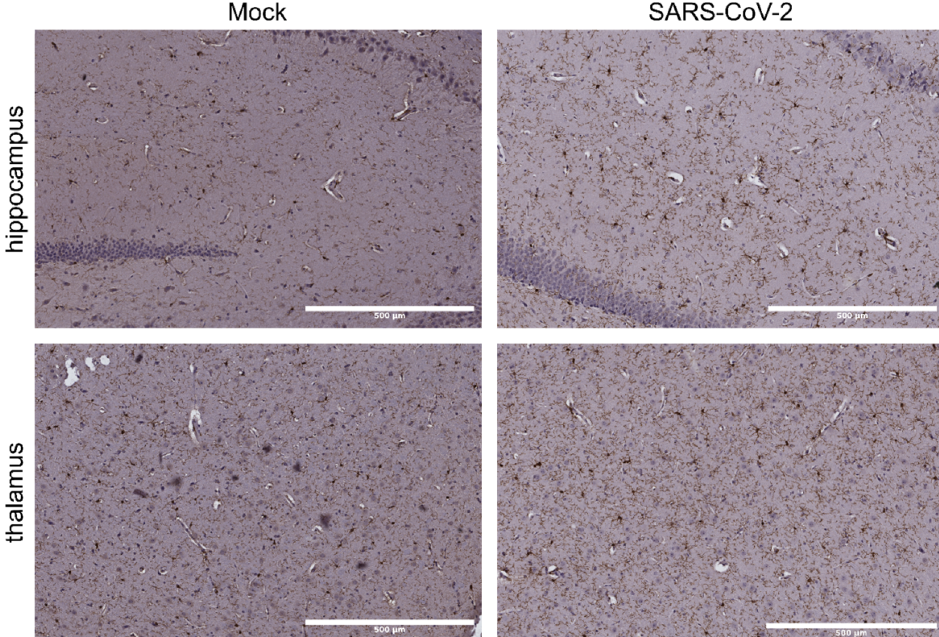
Figure 1. Mild increase in IBA1 staining in the hippocampus and thalamus of SARS-CoV-2-infected hamsters. IHCwith IBA1 and counterstained with hemotoxylin was performed in the hippocampus (top row) and thalamus (bottom row) of brain sections taken from hamsters that were either mock- infected (left column) or infected with SARS-CoV-2 (right column). Microglia in infected tissue, particularly the hippocampal region, show changes in phenotype such as thickening and increased staining of processes, and an increase in staining of the soma of some cells. Microglia remain in a ramified state; activated microglia with amoeboid phenotypes were not observed. Scale bar indicates 500 µm.